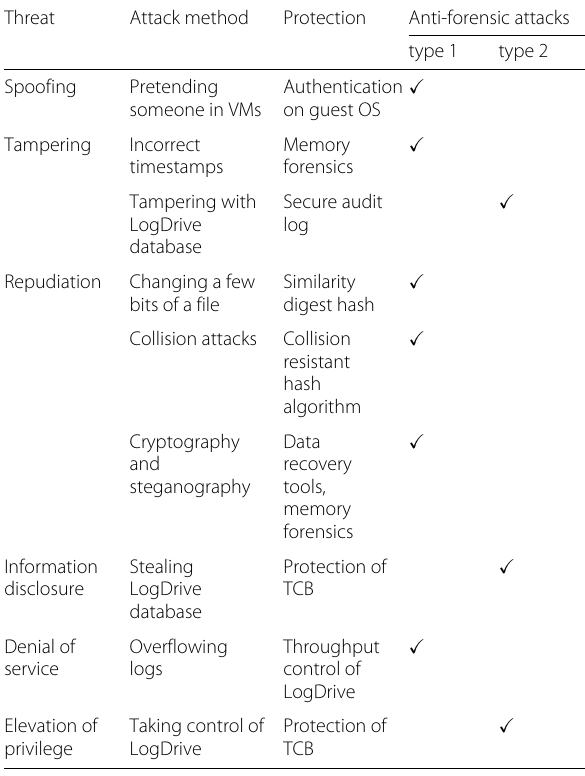
Table 9 The STRIDE threats of